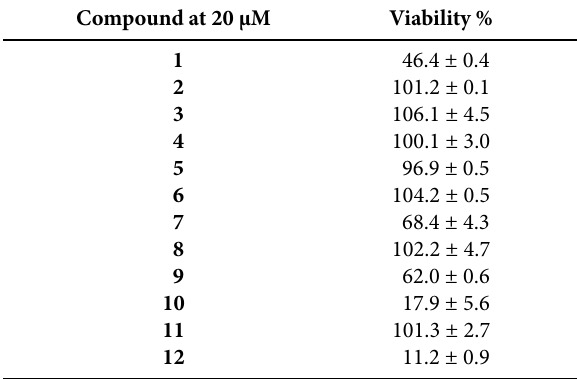
Table 7. Percentage parasite ( Trypanosoma brucei ) viability ± SD obtained for the compounds 1 – 12 . Compound at 20 µM Viability